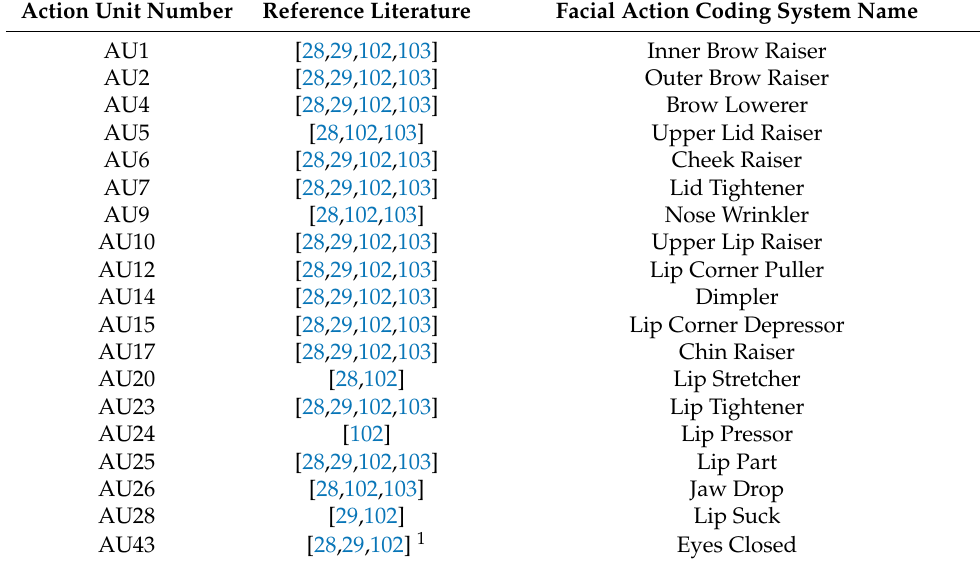
Table 3. List of extracted action